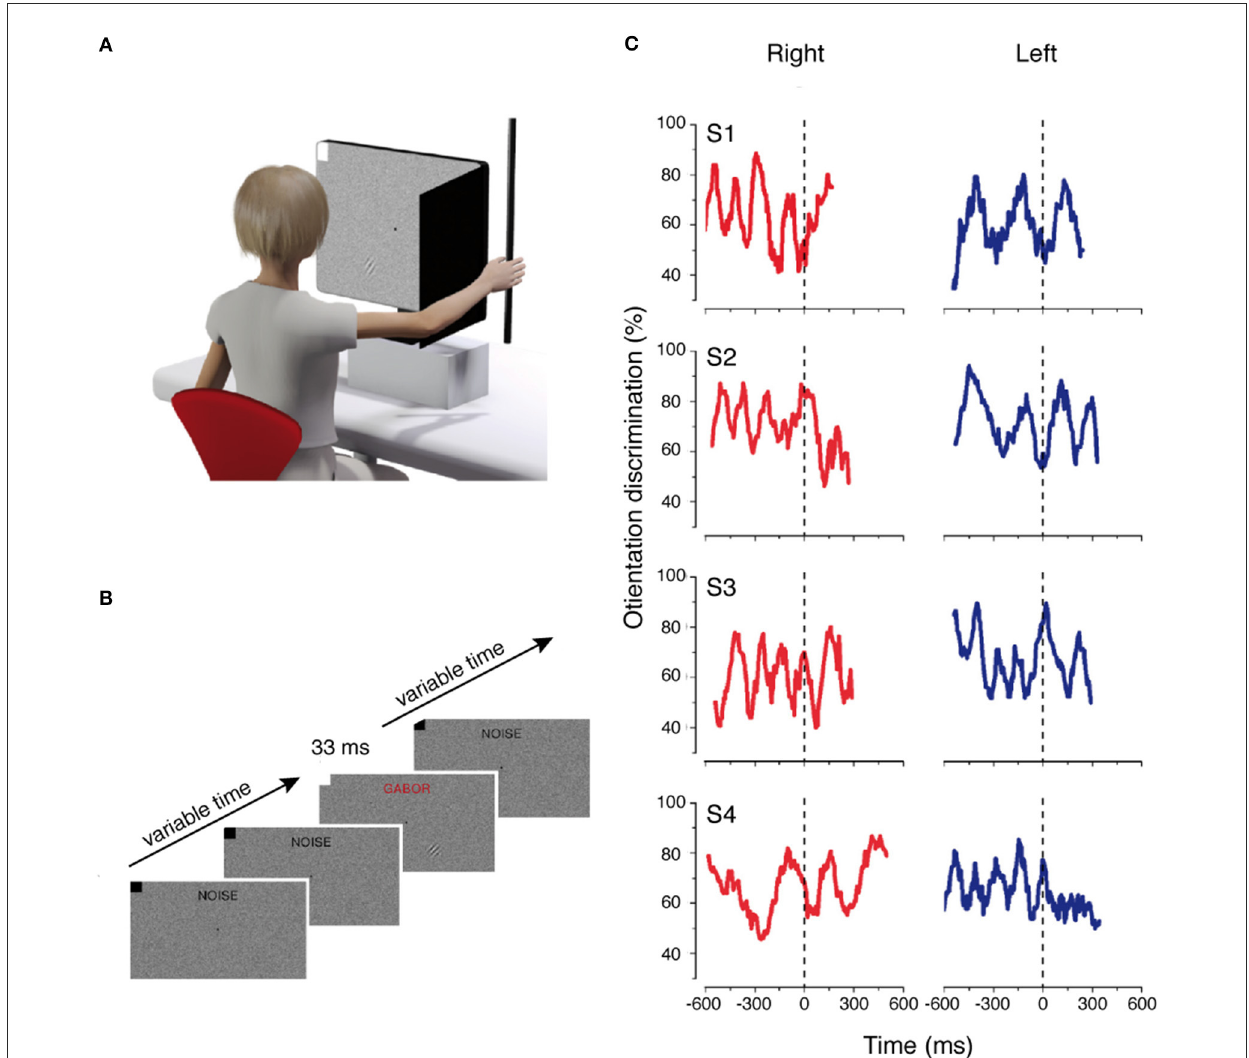
FIGURE3 Rhythmic oscillations of contrast sensitivity synchronized with hand movements. (A) Experimental setup of the motor and visual tasks. (B) Example of trial sequence. Visual noise and fixation point were presented from the beginning of the trial to the end. At a random time from the start of the trial, a Gabor stimulus was displayed to the lower right or to the lower left of fixation. (C) Time course of the orientation discrimination responses for each participant aligned with the onset of the hand movement. Modified from Tomassini et al.